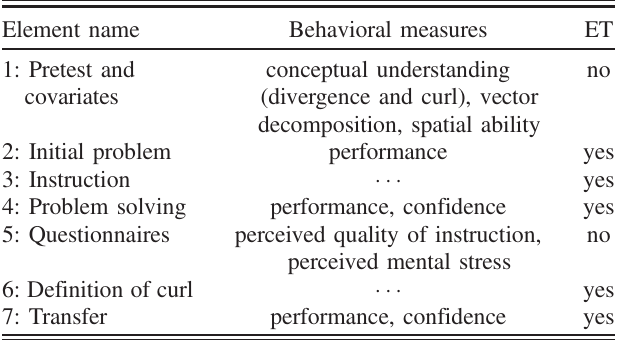
TABLE I. Elements of the experimental procedure and measures or variables [eye tracking (ET)].